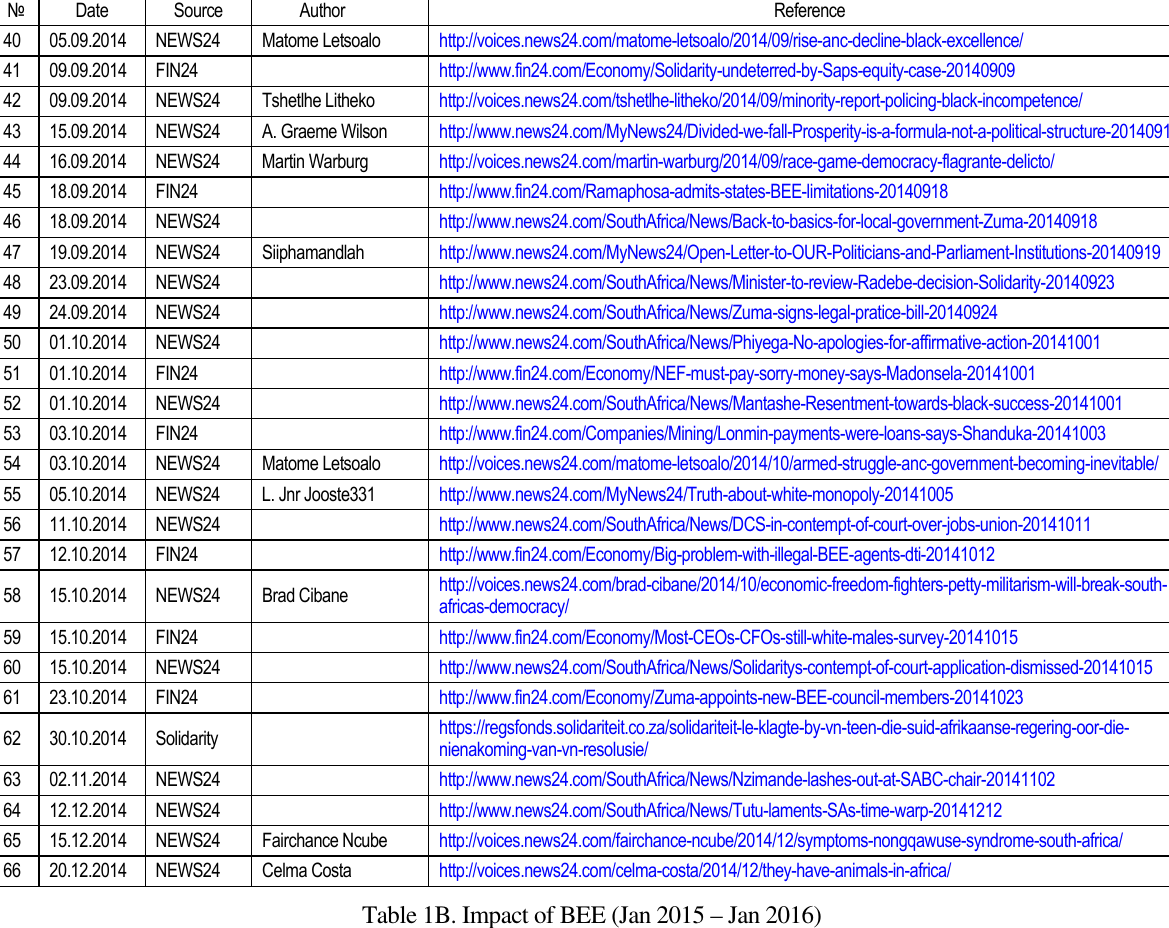
Table 1A (references) (cont.). Impact of BEE (Jan-Dec